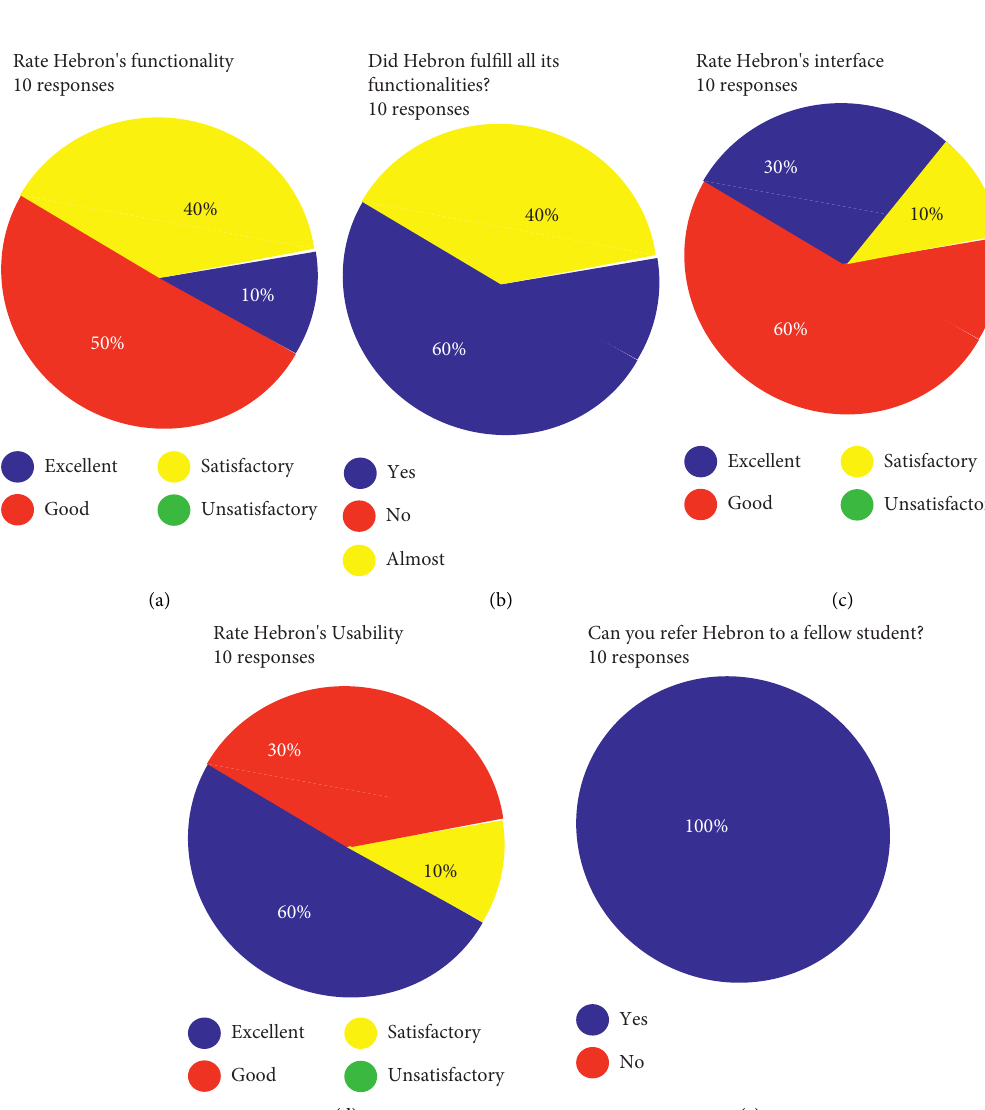
Figure 9: Web server